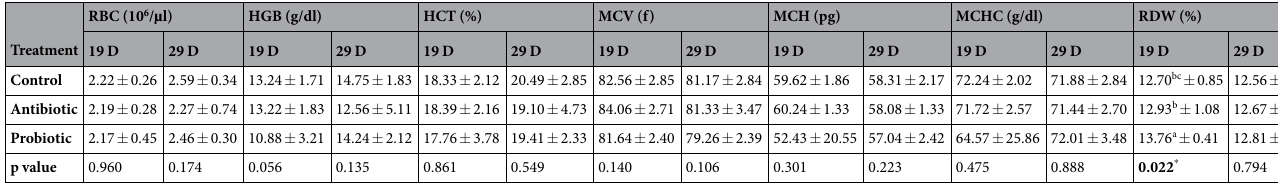
of bacteria that elicits an immune response. Transiently higher LYM counts at day 19 were indicative of a response to the presence of specific immune provoking bacteria. These counts usually normalises when bacterial cell num- bers are brought under control, or after a few days when the body develops tolerance to the antibiotics. Both these responses are undesired. As energy for growth is relayed to elicit an immune response, probiotics showed the opposite and did not elicited an immune response, which is desirable. At day 29, no significant differences were recorded in WBC, HET, LYM, MONO, EOS and BASO counts for broilers from the different treatment groups (Table 1). Lymphocytes are the major circulating immune cells in birds and HET are functionally equivalent to neutro- phils that participate in inflammation and phagocytosis. A high HET/LYM ratio and high glucocorticoid level is an indication of stress 37,38 . High HET/LYM ratios have also been associated with increased mortality 39 . No significant differences were recorded between the mean HET/LYM ratios of broilers from the different treatment groups at day 19 (p = 0.737) and day 29 (p = 0.357) (Supplementary Table S2). Thrombocytes stop bleeding by clumping and plugging injured blood vessels. No significant differences were recorded in thrombocyte counts for the different treatment groups at day 19 (p = 0.121) and day 29 (p = 0.350) (Supplementary Table S2). At day 19, broilers from the different treatment groups had no significant differences in total red blood cell (RBC), haemoglobin content (HGB), haematocrit content (HCT), mean corpuscular volume (MCV), mean cor- puscular haemoglobin (MCH) and mean corpuscular haemoglobin counts (MCHC); listed in Table 2. The eryth- rocyte cell distribution (RDW) of broilers from different treatment groups at day 19 were significantly different (p = 0.022). Broilers receiving the multi-strain probiotic had a higher mean RDW at day 19, compared to the anti- biotic (p = 0.033) and control (p = 0.009) groups. No significant differences were recorded between the antibiotic and control treatment groups. Higher RDW levels may be due to older age of RBC, mixed deficiency (iron, B12 or folate), recent haemorrhage and false positive results from EDTA anticoagulated blood 40,41 . Results suggest that probiotic-treated broilers may in some way allow for RBC to age further before being recycled, as RDW increases with cell age. The relatively small RDW changes supports this interpretation, as the differences would have been larger in the event of deficiency or haemorrhage. Broilers receiving different treatments at day 29 had no signifi- cant differences in their RBC, HCT, MCV, MCH, and MCHC and RDW counts. Bursa of Fabricius and the spleen are lymphoid organs which forms part of the avian immune system 42 . The spleen filters and regenerates antibodies, whereas the bursa of Fabricius is the site of haematopoiesis responsible for B-cell production. Immune organ weights are weighed to evaluate the immune status of broilers 23 . The bursa of Fabricius is the primary lymphoid and probiotic administration can lead to an increase in weight 43 , which may be considered an improvement of the immune system 44 , however, excessive responses depress growth per- formance 45 . Administration of either the multi-strain probiotic or antibiotics did not alter the relative weights of the spleen, bursa of Fabricius and the spleen: bursa of Fabricius ratio at days 19 and 29 (Supplementary Table S3). Conflicting results were reported for the probiotic Protexin ® ( Lactobacillus plantarum , Lactobacillus bulgari- cus , Lactobacillus acidophilus , Lactobacillus rhamnosus , Bifidobacterium bifidum , Streptococcus thermophilus , Enterococcus faecium , Aspergillus oryzae and Candida pintolopesii ) 28,46 . Pourakbari et al . 28 observed no differences in spleen or bursa weights of broilers raised in cages, but Dizaji et al . 46 reported an increase in spleen weights when broilers were raised on the floor. Concluded from these studies, differences in rearing conditions, i.e. hous- ing, feed composition and environmental factors, probably played an important role for the observed discrepan- cies. In our study the multi-strain probiotic ( L . crispatus DPN167, L . salivarius DPN181, L . gallinarum DPN164, L . johnsonii DPN184, E . faecalis DPN94 and B . amyloliquefaciens DPN123) was administered to broilers reared in cages, which could be the reason why no differences in immune organ weights were observed. It may thus be more applicable to study the effect of the multi-strain probiotics on broilers raised under less hygienic conditions, as cage rearing is considered more hygienic than pen rearing 27 . Relative gizzard to body weight ratio is used to assess the efficiency of mechanical feed digestion. Supple- mentation of feed with either the multi-strain probiotic or antibiotics had no significant effect on the relative gizzard weights at days 19 and 29 (Supplementary Table S4). Researchers using a multi-strain probiotic which consisted of L . acidophilus , Lactobacillus casei , Pediococcus acidilactici , Bacillus subtilis and Saccharomyces boulardii 47 and a single strain probiotic Eubacterium sp. 48 similarly reported no significant differences in the relative gizzard weights. The surface of the small intestine contains villi that increases the surface area and leads to increased absorp- tion. At the base of the villi, tubular invaginations (crypts) extend into connective tissue to form enterocytes